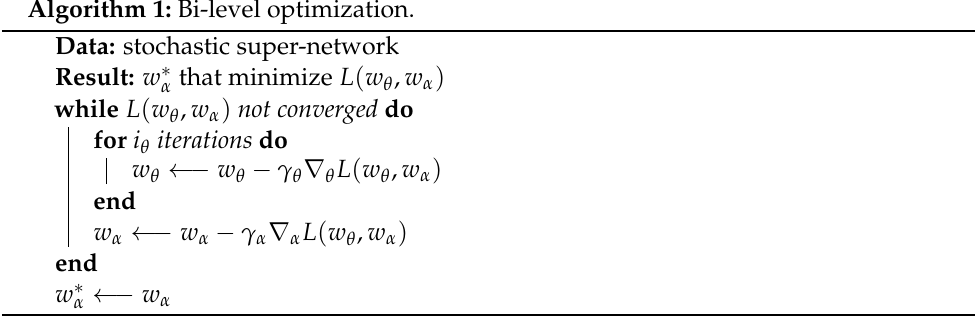
Algorithm 1: Bi-level